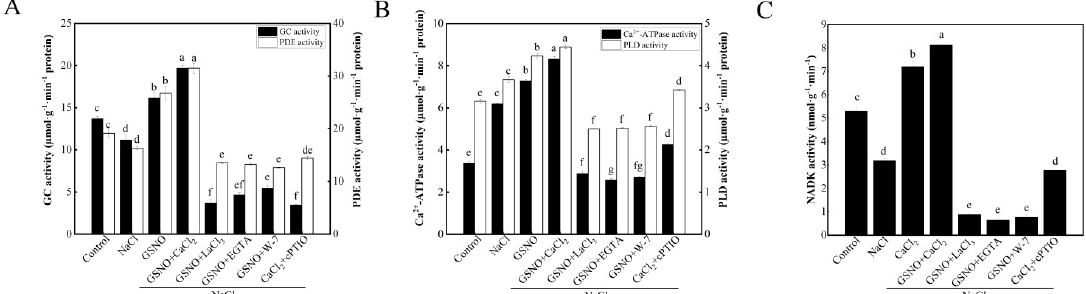
Figure 5. Effects of NO on downstream target enzymes related by Ca 2+ /CaM in tomato seedlings under salt stress. ( A ): GC and PDE activities; ( B ): Ca 2+ -ATPase and PLD activities; ( C ): NADK activity. The values (means ± SE) are the averages of three independent experiments ( n = 15). The columns labeled with different small letters indicate significant differences between treatments by Tukey’s multiple comparison test ( p <